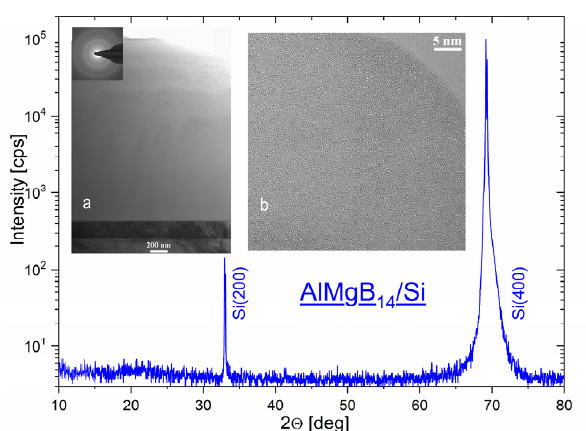
Figure 1. Main frame Cu K α radiation of 0.4- µ m-thick AlMgB 14 film magnetron sputtered onto Si(100) wafer at 550 ◦ C. Insets–XRD Θ -2 Θ scan in ts: a –SAED pattern and b –high resolution TEM image of RF15-2(2.12 µ m) AlMgB 14 film grown onto Si(100) at 250 ◦ C. Electron microscopy images provided courtesy of Dr. Jun